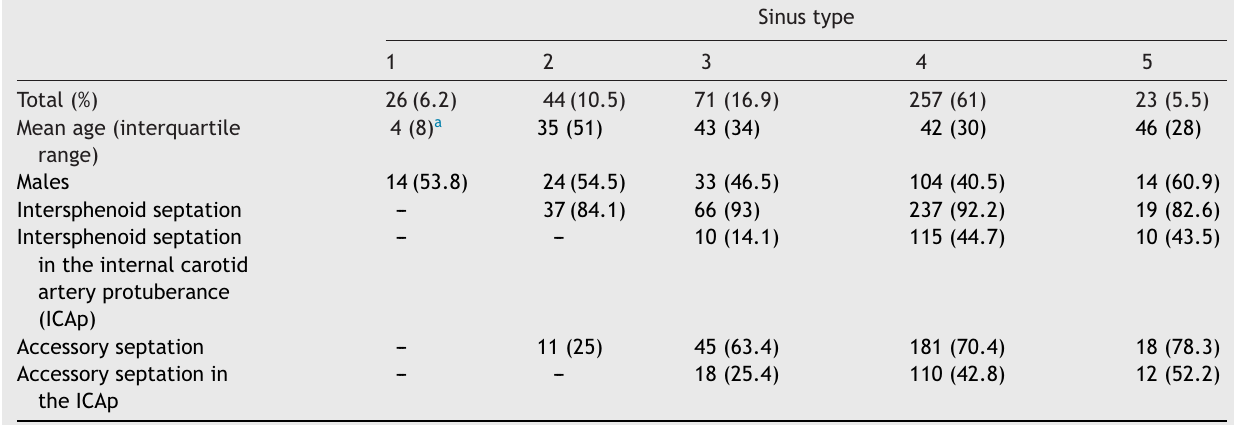
Intersphenoid and accessory septations by sinus type.